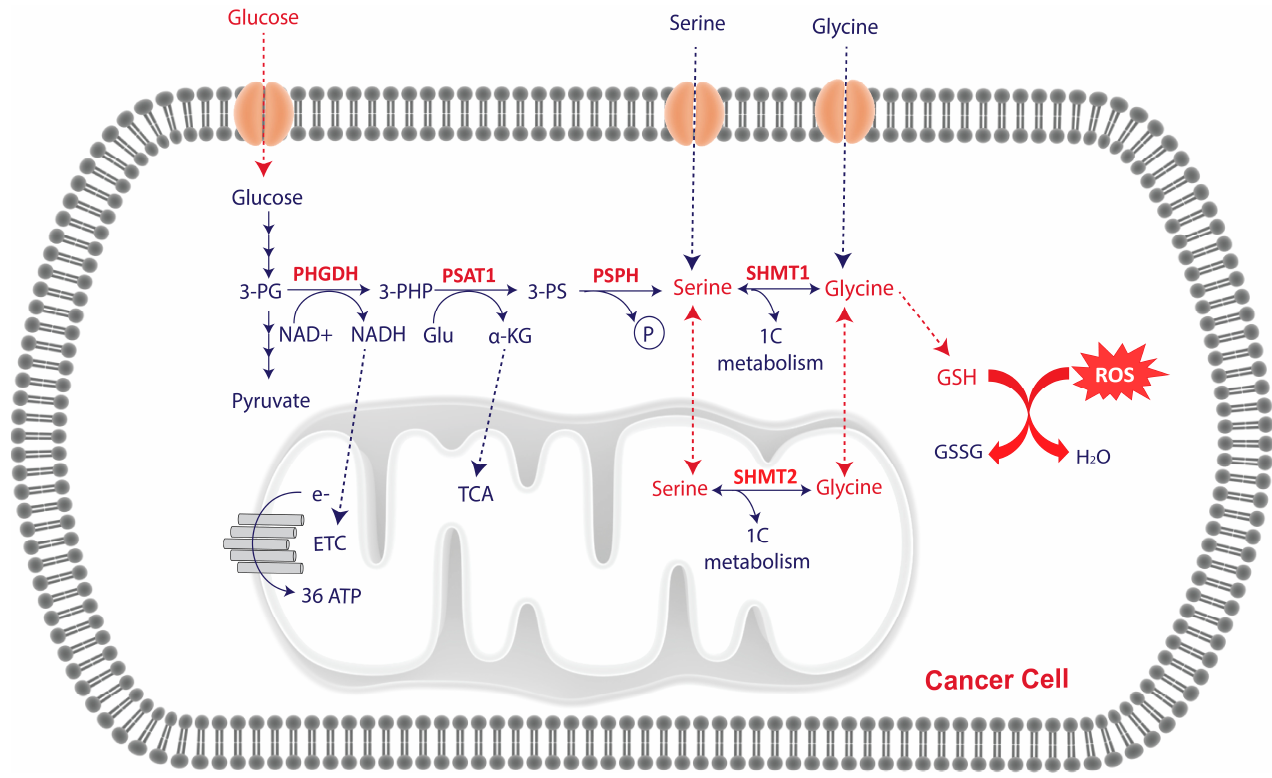
Figure 1. Overview of serine/glycine biosynthesis pathway activation in cancer. Serine/glycine biosynthesis pathway branches from the glycolysis, in which the intermediate 3P-glycerate is converted into serine and glycine after a chain of consecutive enzymatic reactions controlled by PHGDH, PSAT, PSPH, and SHMT1/2 enzymes. Cancer cells are characterized by activation of de novo serine/glycine biosynthesis to meet their high biosynthetic and energetic requirements. Activation of de novo serine/glycine biosynthesis and one-carbon (1C) metabolism promote purine and pyrimidine synthesis and supports lipid metabolism, as well as produces reductive equivalents to control redox homeostasis and α -ketoglutarate and S-adenosyl methionine (SAM) to regulate DNA and histone methylation. This representation shows the reduction of glutathione disulfide (GSSC) to glutathione (GSH), which is a tripeptide thiol antioxidant, composed of glycine, cysteine, and glutamic acid, and one of the main regulators of reactive oxygen species